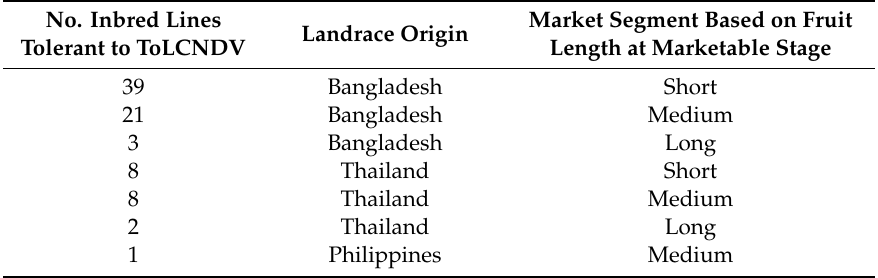
Table 4. Ridge gourd lines (82) of di ff erent market segments tolerant to the tomato leaf curl New Delhi virus (ToLCNDV), developed from diverse germplasm at the World Vegetable Center.